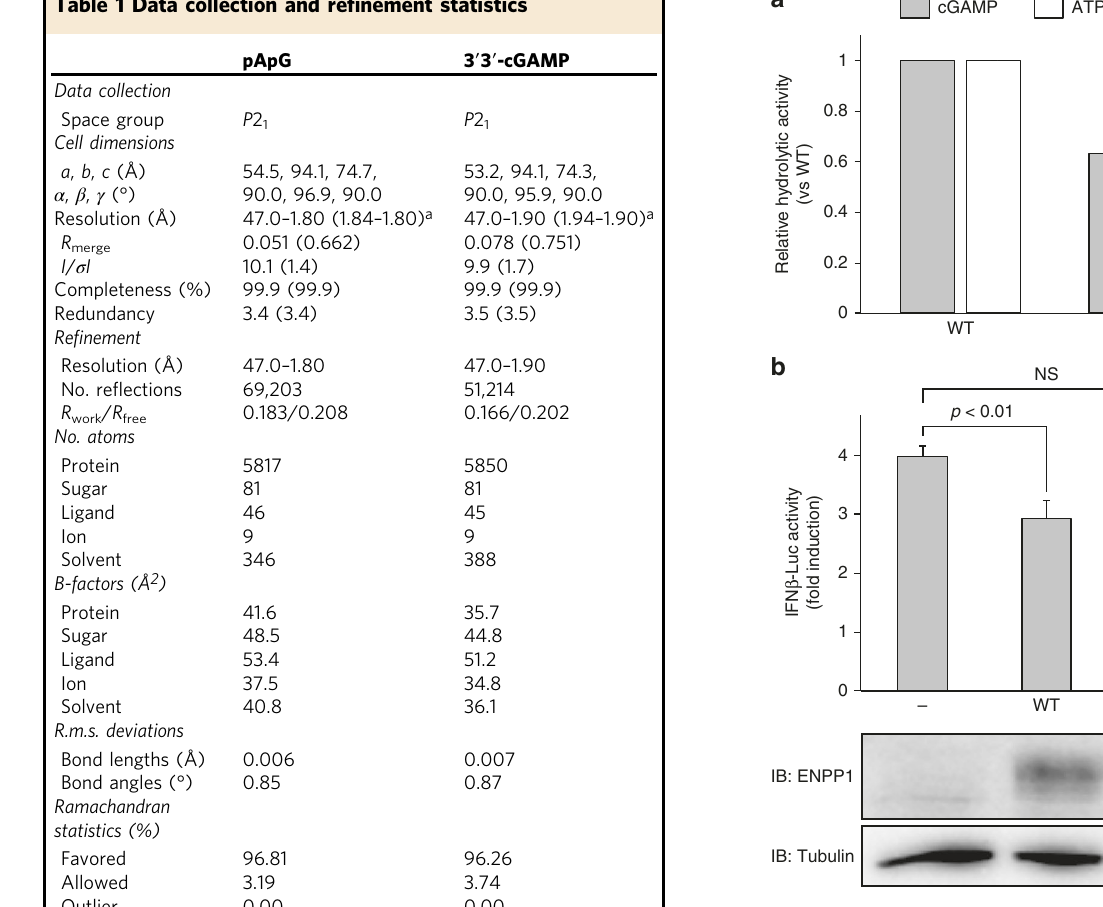
Fig. 3 Mutational analysis. a Hydrolytic activities of wild-type (WT) and the S514L mutant of ENPP1 toward 2 ′ 3 ′ -cGAMP or ATP. Data are means ± s.d. ( n = 3). b IFN- β suppression by WT and the S514L mutant of ENPP1. The ENPP1 protein was expressed in THP-1 cells, and the IFN- β induction was then examined by a luciferase assay. Data are means ± s.d. ( n = 3). One- way ANOVA followed by a post-hoc Tukey HSD test was performed. The cell lysates were immunoblotted with the indicated antibodies. NS, not signi fi